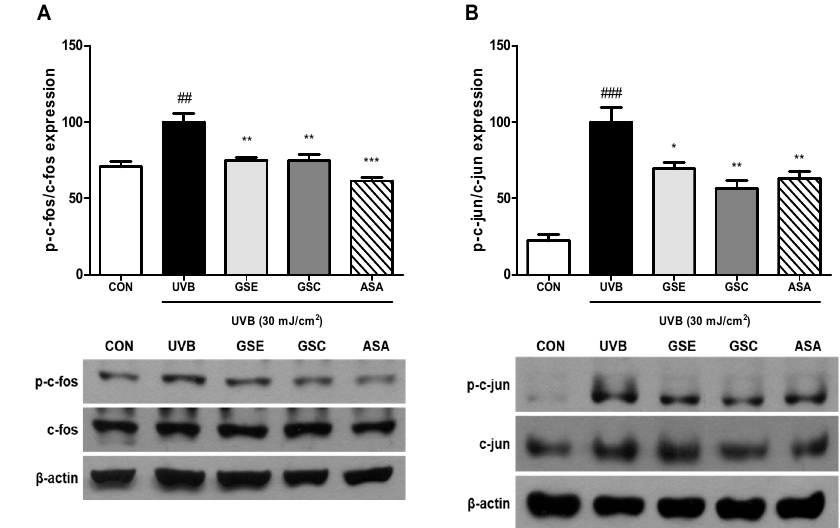
Figure 4. Effects of ginseng seed embryo (GSE) and coat (GSC) on the phosphorylation of activator protein-1 (AP-1) proteins in UVB-irradiated Hs68 cells. Control or UVB-irradiated cells were treated with/without GSE or GSC and subjected to western blotting for ( A ) p-c-fos and ( B ) p-c-jun levels. The relative levels of phosphorylated protein were normalized to those of total AP-1 proteins. Values are expressed as the mean ± standard error ( n = 3). ## and ### p < 0.01 and 0.001, significant difference compared to control; *, **, and *** p < 0.05, 0.01, and 0.001, respectively, significant difference compared to UVB-irradiated group. ASA (ascorbic acid, 100 μ M), positive control.